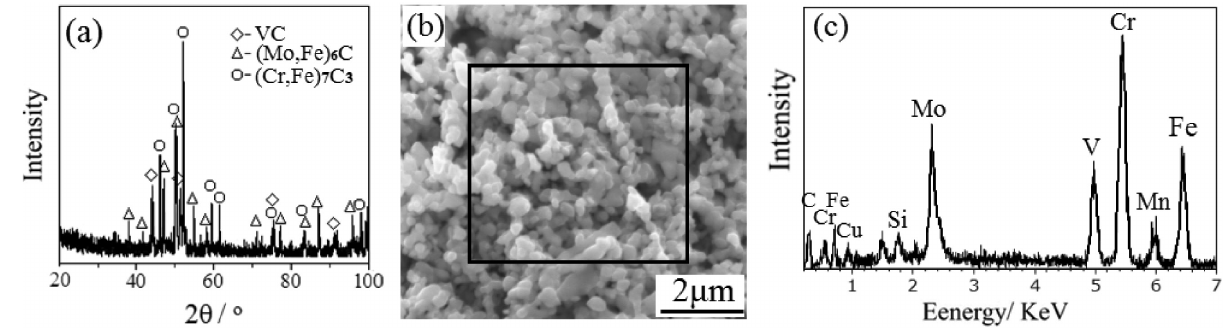
Fig. 2: XDR and EDS analyses of carbides in forged and annealed H13 steel (steel B). (a) XRD pattern of carbides; (b) extracted second phase; (c) EDS spectrum of selected area in